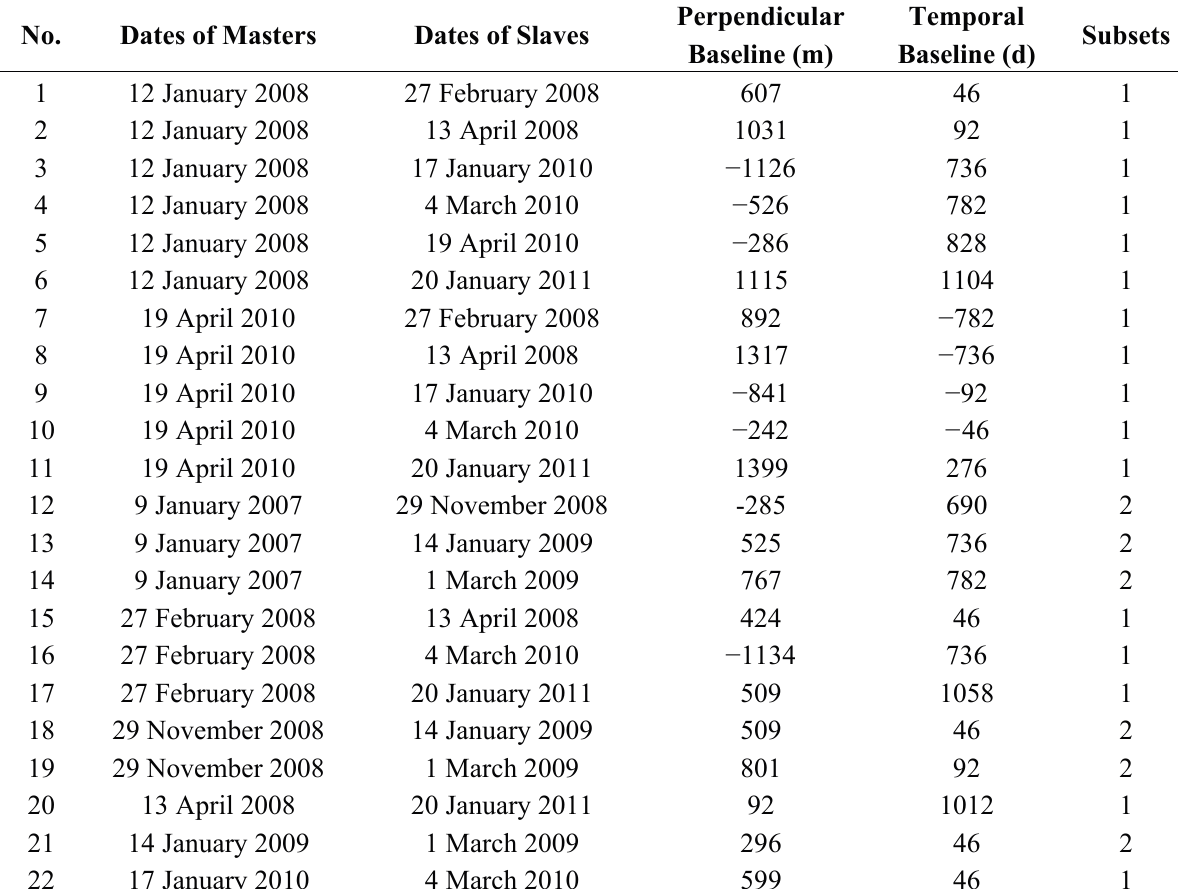
Table 2. The perpendicular and temporal baselines of image pairs from ALOS PALSAR for two small baseline